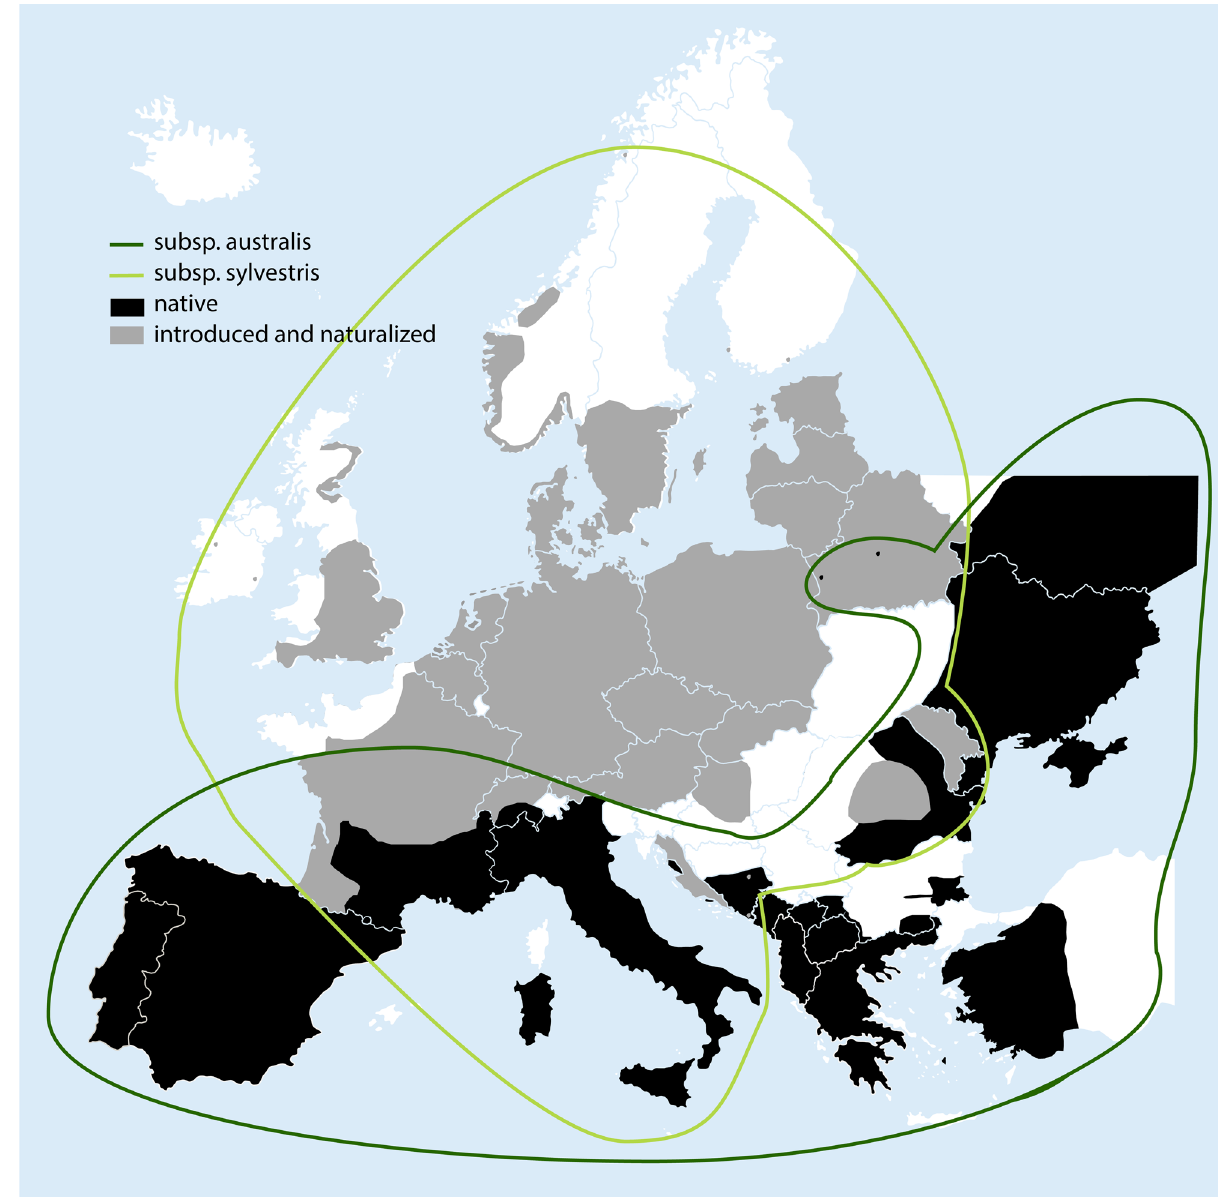
Figure 8. Distribution of Tulipa sylvestris in Europe. Black color indicates native occurrence and grey naturalized . Precise occurrence within each country is shown where available. Created with Adobe Illustrator 26.0.3, background map: Shutterstock, https:// www. shutt ersto ck. com